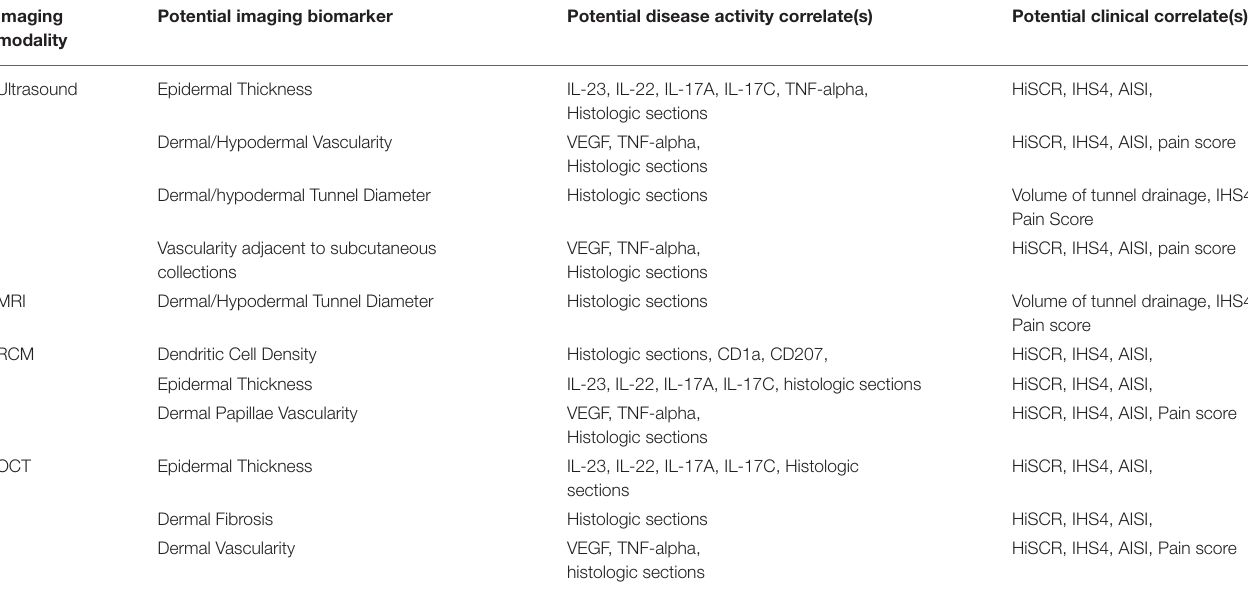
TABLE 1 | Potential imaging-based biomarkers identified for further investigation from this scoping review. Imaging